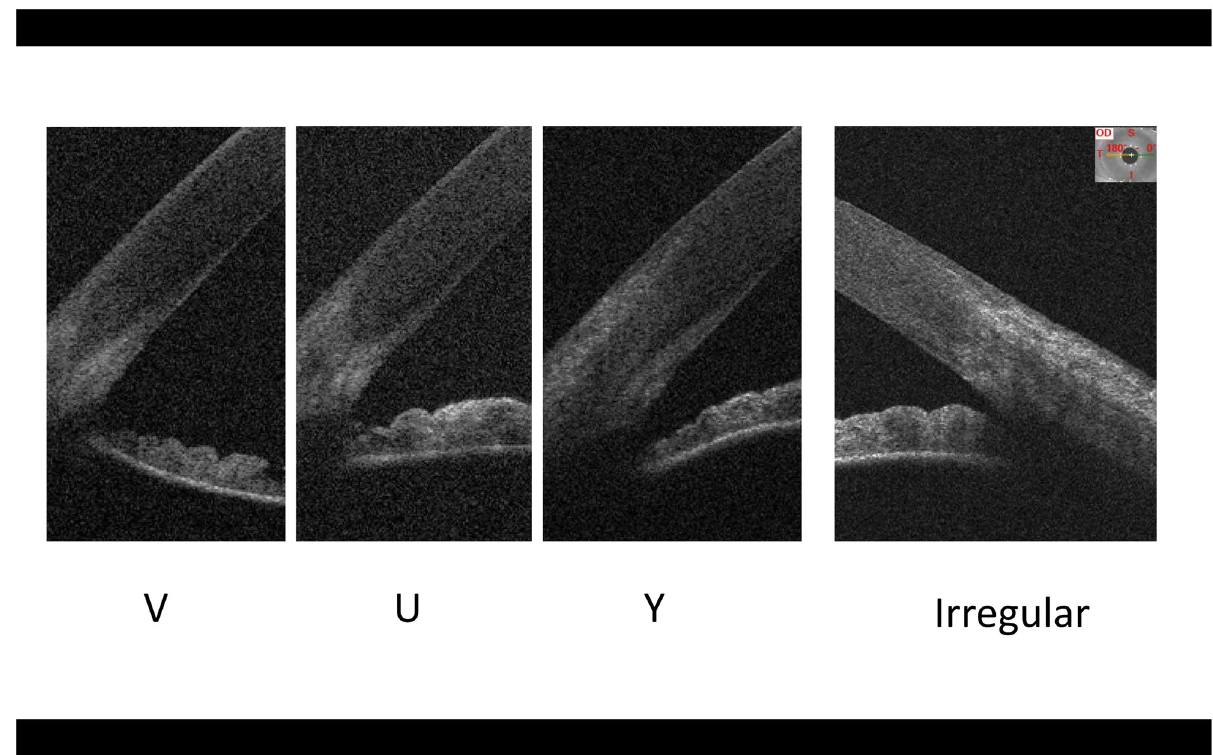
Fig 2. The shape of corneo-scleral junction. Examples of different tomographic reflectivity patterns of corneo-scleral junction at the horizontal corneal meridian: V-, U- and Y-shaped transition (temporal side); irregular transition (nasal side).